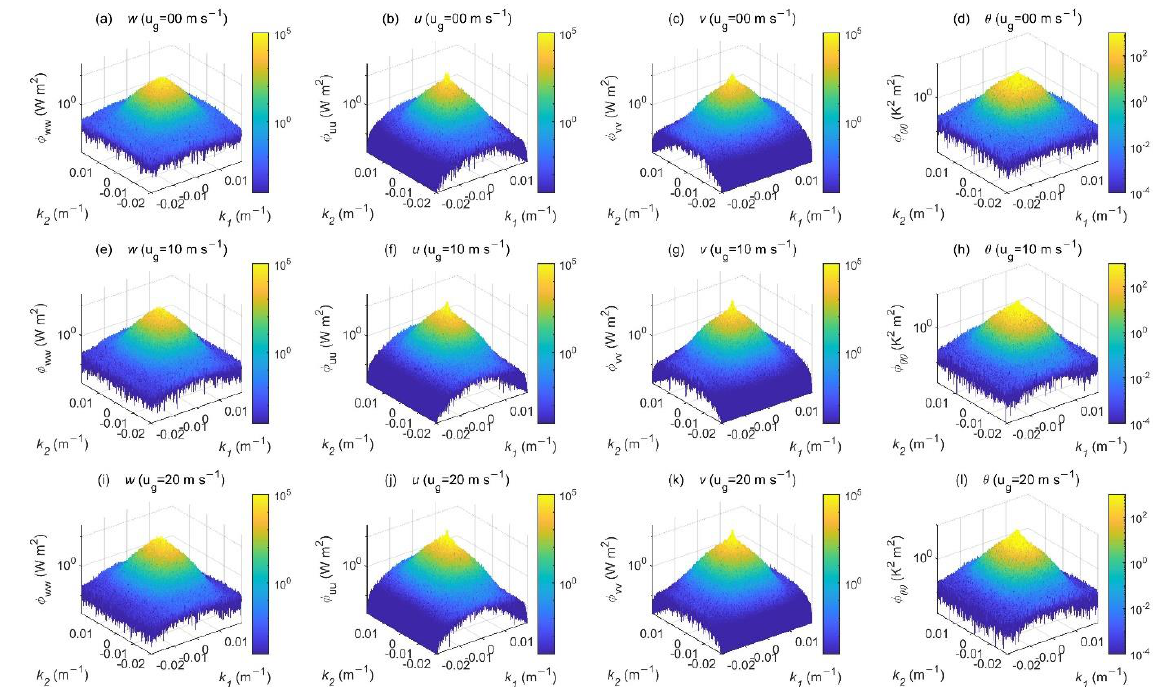
Figure 8. As in Figure 7 at z / z i = 0.1.